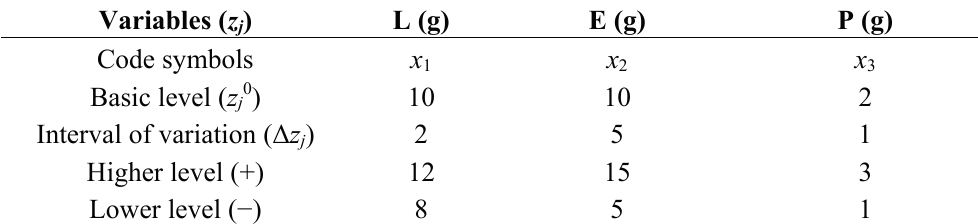
Table 2. Real values and code symbols of the variables used in the optimization procedure. L, rapeseed lecithin ethanol soluble fraction; E, anhydrous ethanol; P, Polysorbate 80.